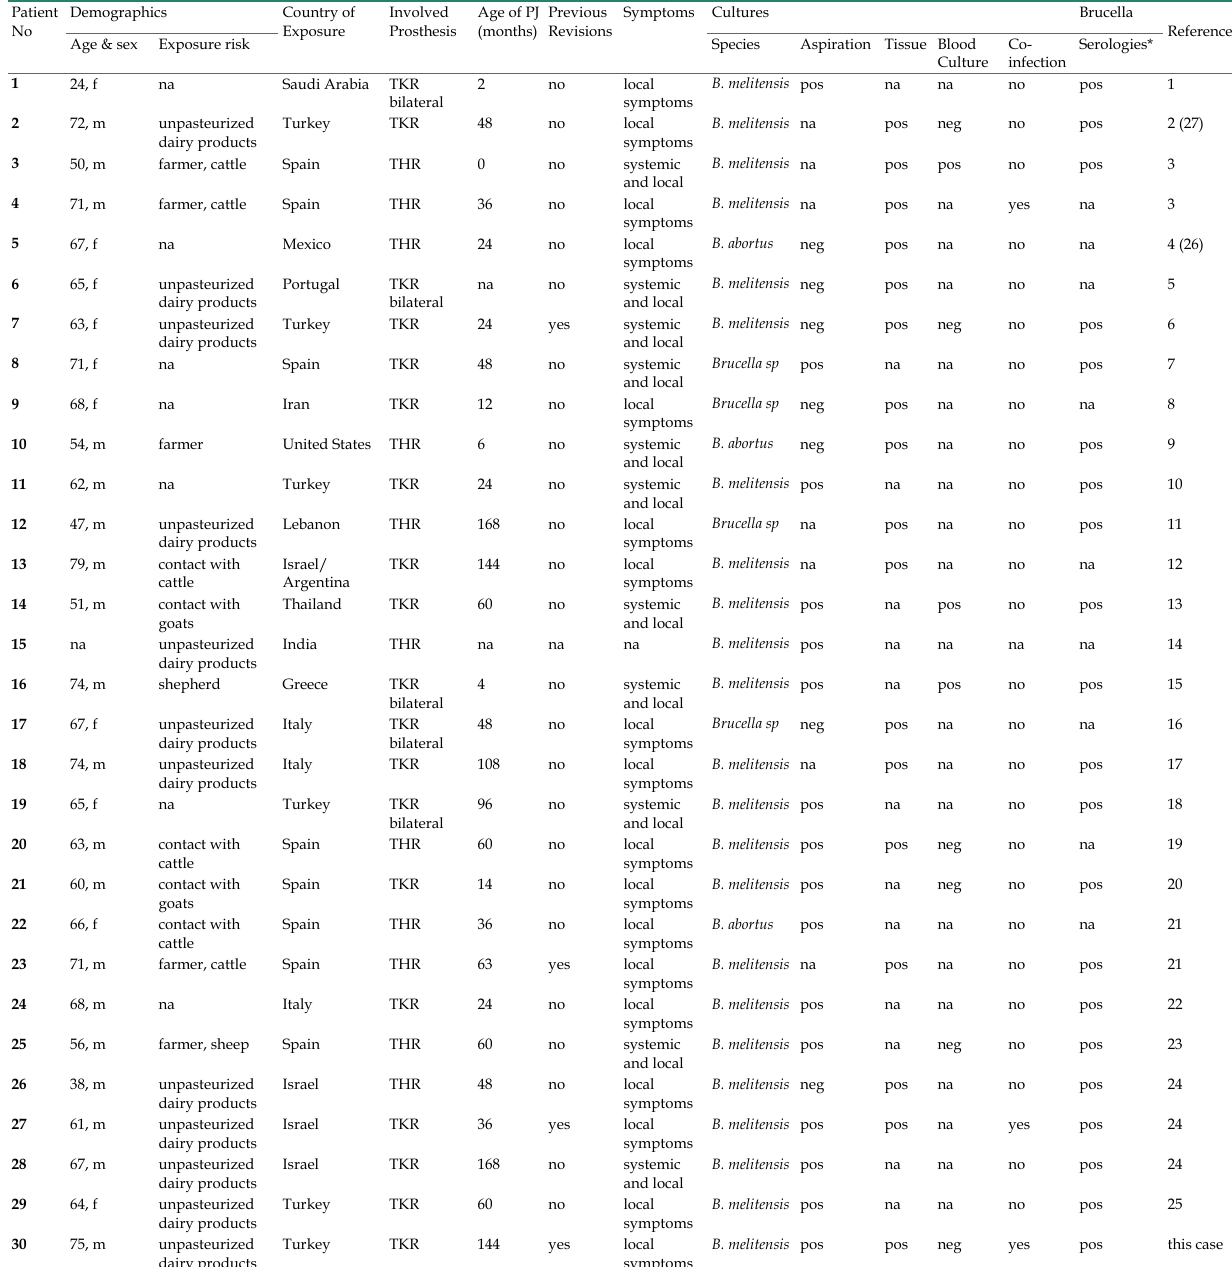
Table 1. Demographics and